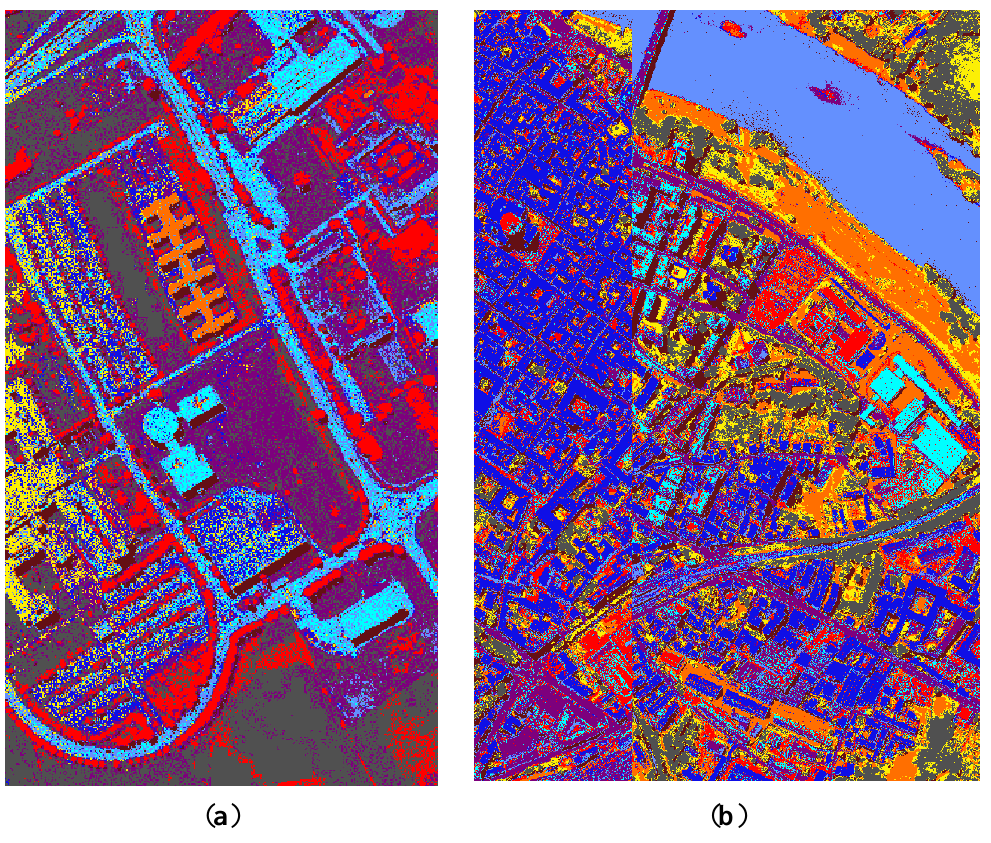
Figure 9. The thematic maps of ( a ) Pavia University, and ( b ) Pavia City Center using the proposed FKNFLE algorithm.